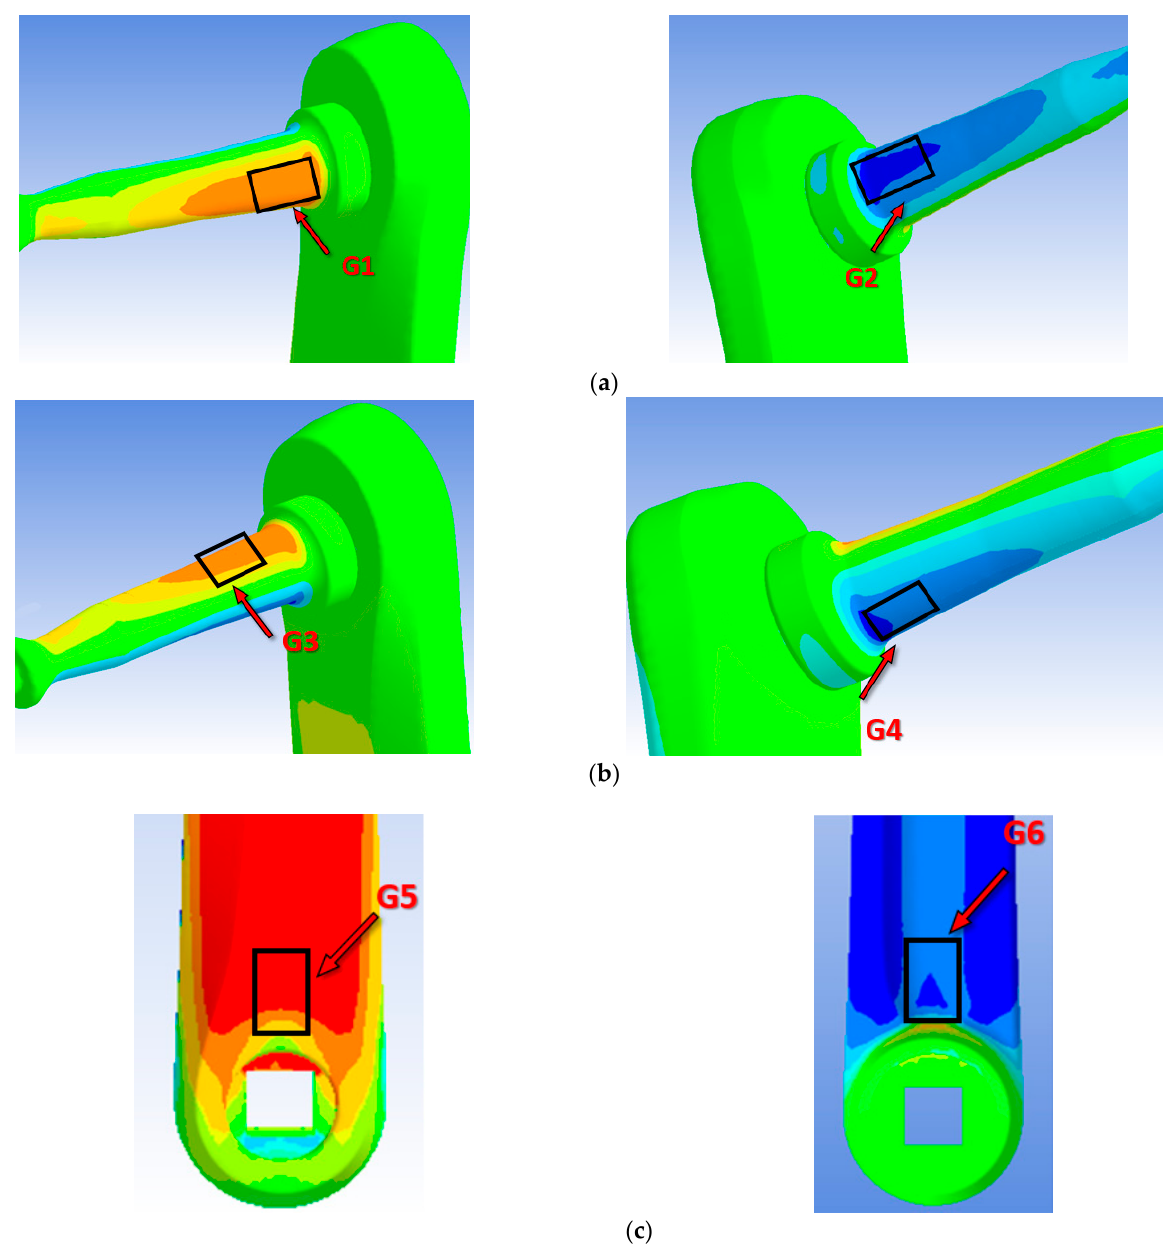
Figure 5. Gauges positioning in the different pedal areas. ( a ) Wheatstone bridge 1. ( b ) Wheatstone bridge 2. ( c ) Wheatstone bridge 3.